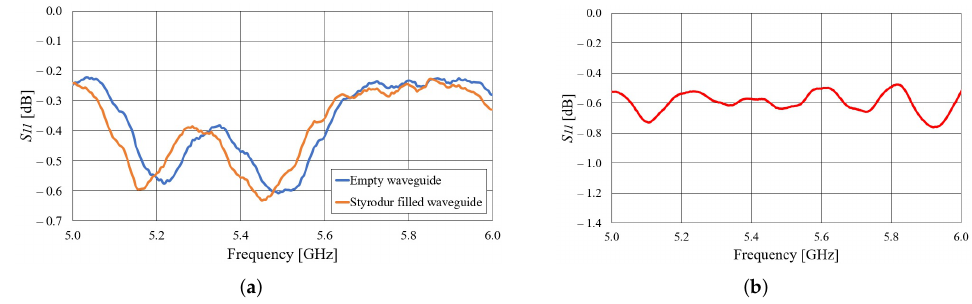
Figure 2. ( a ) Comparison of measured S 11 parameter of empty and Styrodur-filled short-circuited metallic waveguide. ( b ) Measured S 11 parameter of short-circuited textile